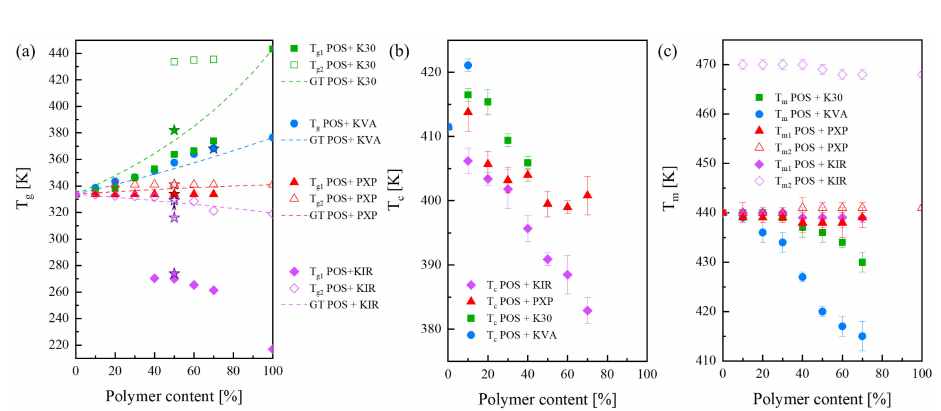
Figure 4. Concentration dependences of ( a ) glass transition temperature, ( b ) crystallization on- set, ( c ) melting point of the investigated POS + K30 (green squares), POS + KVA (blue circles), POS + PXP (red triangles), and POS + KIR (purple diamonds). The star symbols represent the T g values of systems obtained after the HME